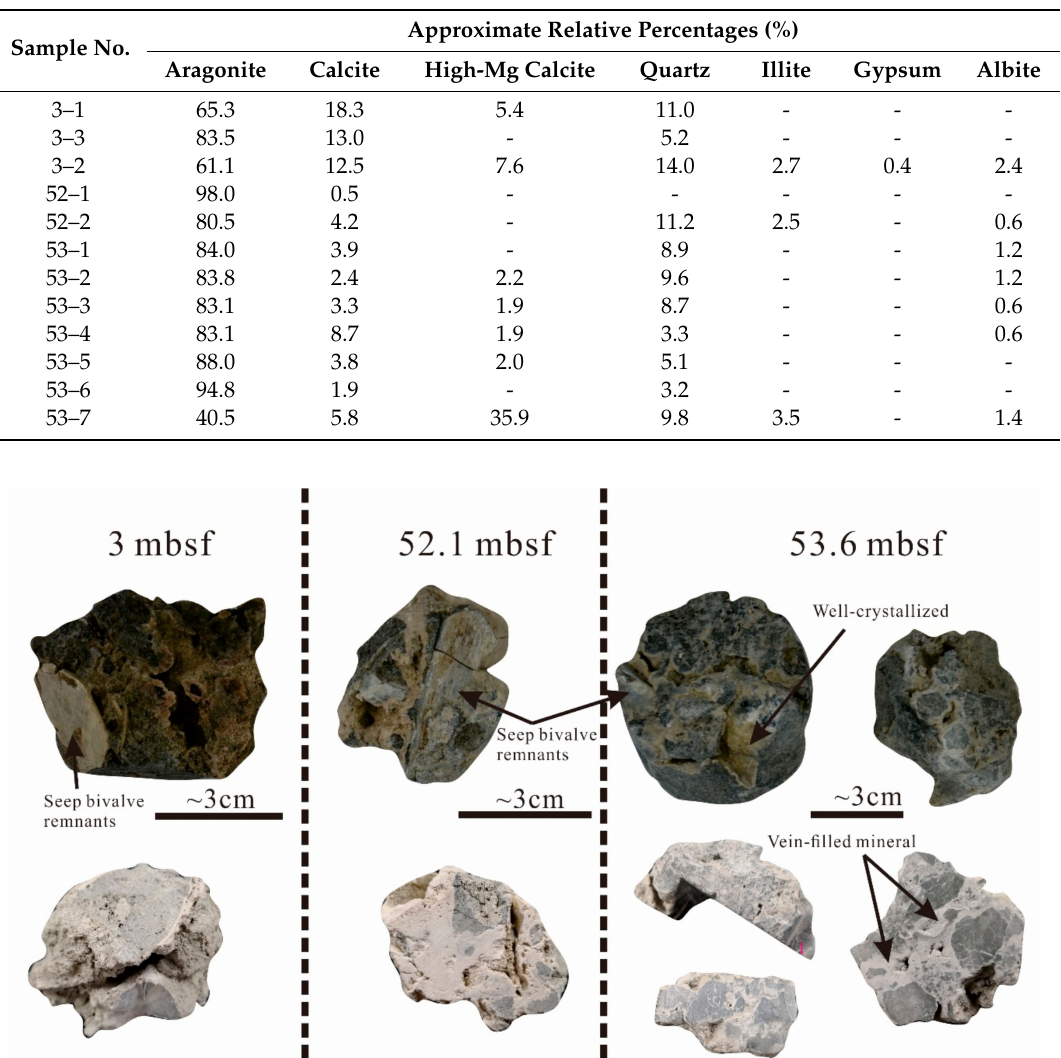
Table 1. Mineral composition of carbonate subsamples from core W08B. Sample No.